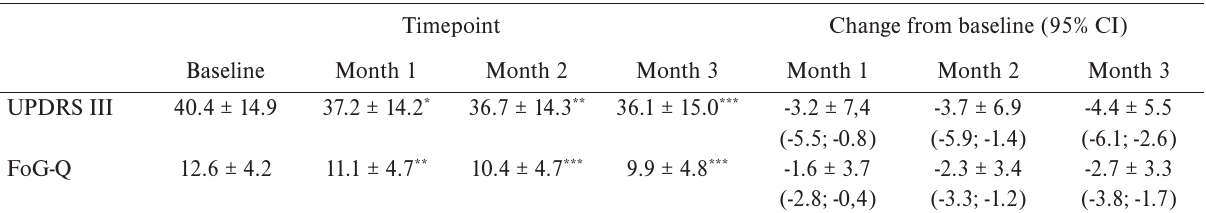
Table 1. UPDRS III and FoG-Q changes.